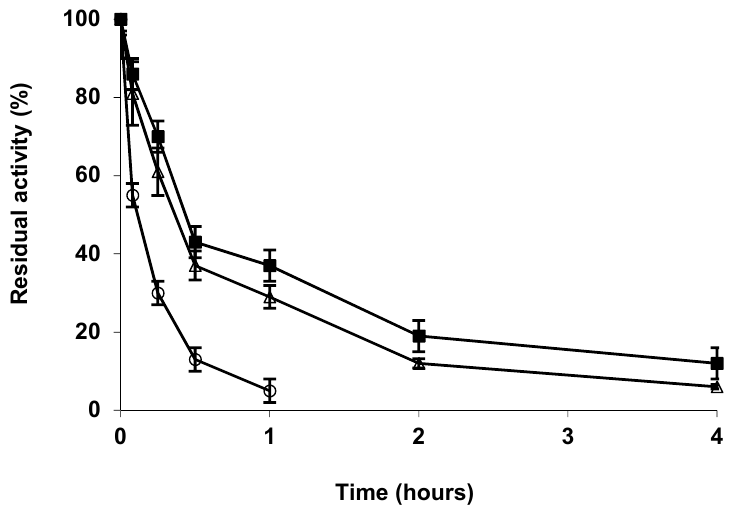
Figure 2. Effect of immobilization pH in the inactivation courses of the different β -gal-MANAE preparations. The inactivation was performed in 25 mM sodium phosphate at pH 7 and 50 ◦ C. The support presented 60 µ mol MANAE groups/g of support. All experiments were performed in triplicate and the values are given as mean value ± the experimental error. Other specifications are described in Methods Section. Squares: β -gal was immobilized at pH 5; Triangles: β -gal was immobilized at pH 7; and Circles: β -gal was immobilized at pH 9.